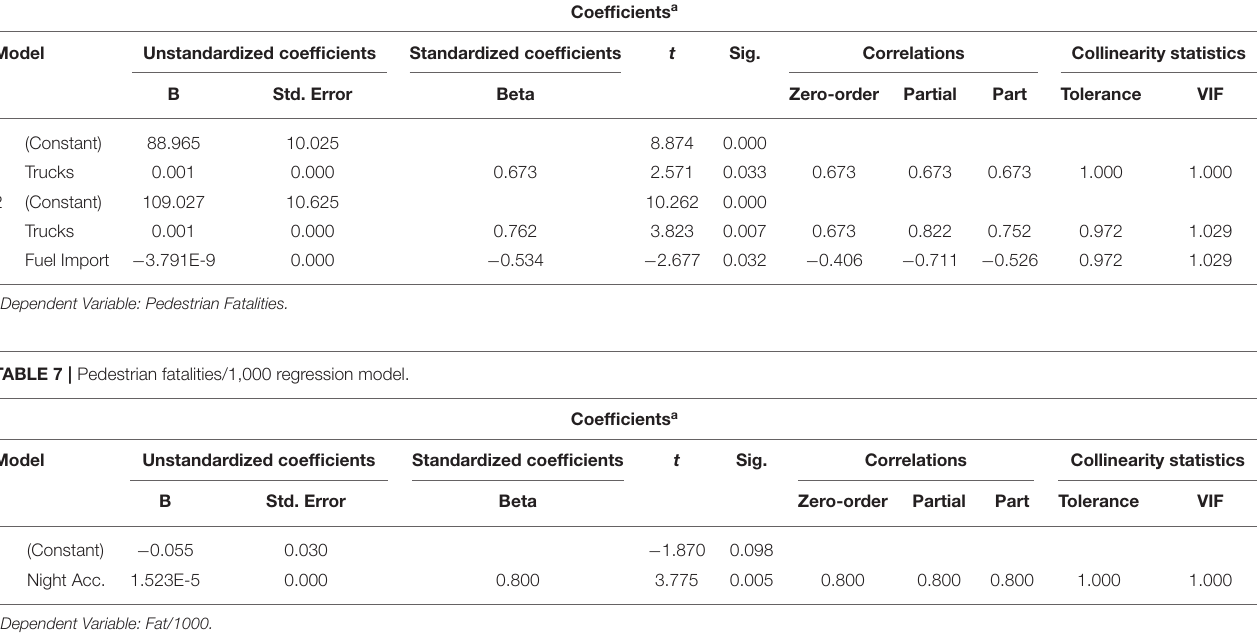
TABLE 6 | Pedestrian count regression model.